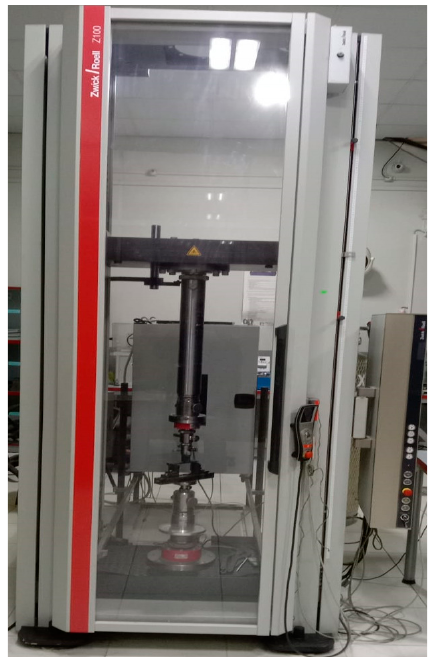
Figure 5. UTM used for the analysis of mechanical properties of the developed composites.